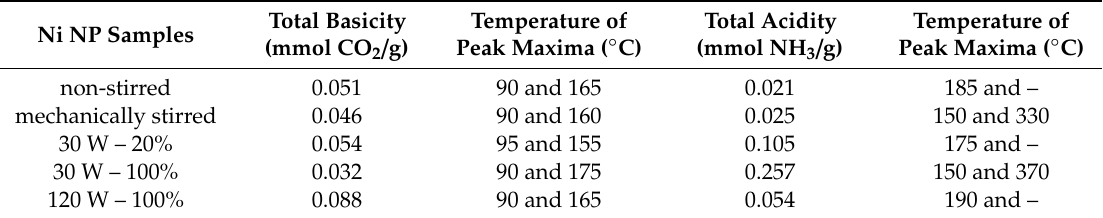
Table 3. Summary of the temperature-programmed desorption (TPD) results for the selected